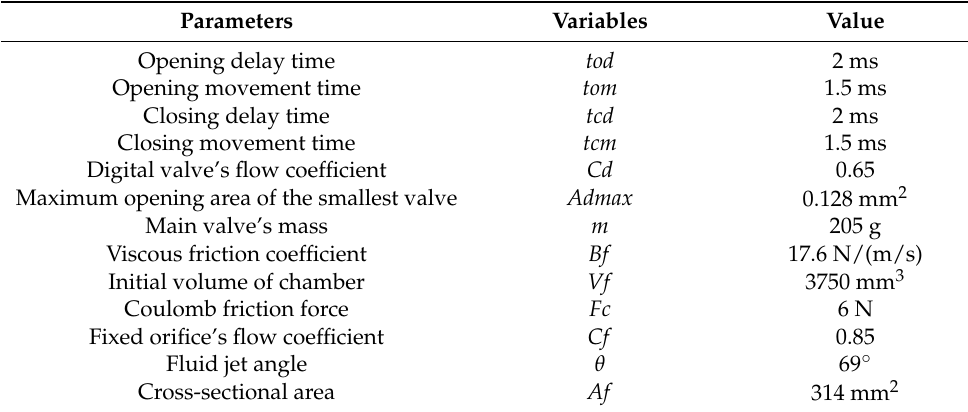
Figure 4. Simulation model of the fuel metering valve system. The main parameters are given in Table 2. Table 2. Main parameters of the entire valve